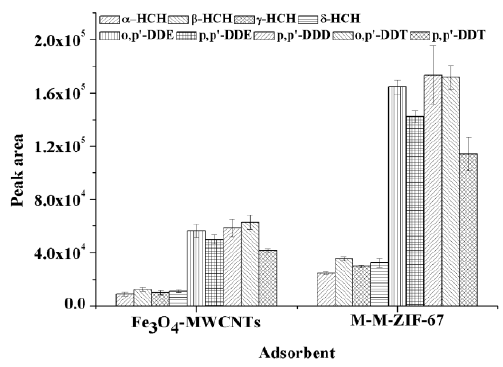
Figure 6. Effect of the sorbent on the adsorption capacities for the nine organochlorine pesticides. Extraction conditions: sample volume, 5 mL; amount of sorbent, 6 mg zeolitic imidazolate framework based on magnetic multiwalled carbon nanotubes and 4 mg magnetic multiwalled carbon nanotubes; and extraction time, 20 min. Desorption conditions: 2 mL of acetonitrile; ultrasonication time, 5 min, and ultrasonication performed one more time. The error bars show the standard deviation of the mean ( n =